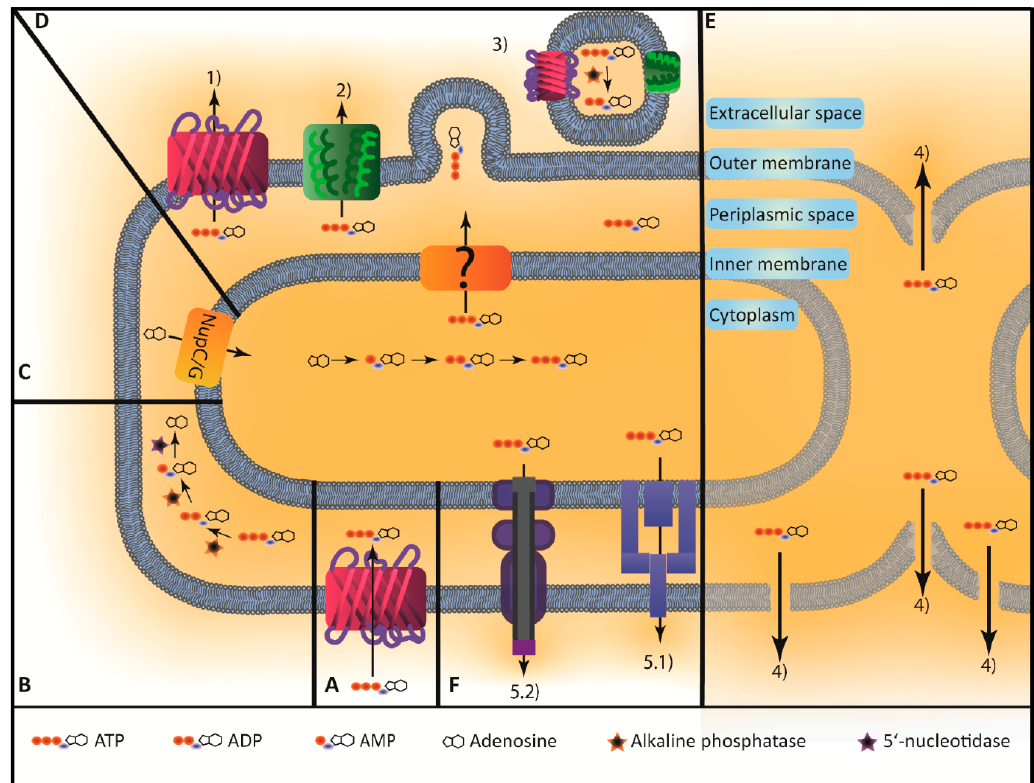
Figure 1. Model of ATP turnover in gram-negative bacteria. ( A ) ATP is taken up by the bacterium, possibly via general porins [41,42]. ( B ) Periplasmic ATP is subsequently hydrolyzed via alkaline phosphatases and 5‘-nucleotidases to ADP, AMP and adenosine [42–46]. ( C ) Adenosine can then be further metabolized or taken up into the cytoplasm via nucleoside permeases like NupC or NupG, where it is recycled to ATP [41,47]. ( D ) ATP is mainly produced in the cytoplasm by the respiratory chain. ATP is then transported into the periplasmic space by a hitherto unknown mechanism ( ? ), since as known so far, gram-negative bacteria do not code for an ATP-ADP translocase homologue. Periplasmic ATP can subsequently be secreted in a growth-dependent manner by non-lytic mechanisms such as 1) general porins [42,72,73], 2) mechanosensitive channels [74,75] or 3) outer membrane vesicles [42,76,77]. Most likely ATP surrounds the bacterial cell in a halo-like manner. It has been shown that outer membrane vesicles contain ATP and have intrinsic ATPase activity. ( E ) It is also conceivable that lysis contributes to measured eATP concentrations during growth 4) [78–82]. ( F ) Possibly, active systems such as specific 5.1) e ffl ux pumps or 5.2) secretion systems for ATP exist, but have not been identified so far [62–67]. If a specific mechanism is predominating in ATP secretion or if a combination of these mechanims are responsible for bacterial eATP remains to be